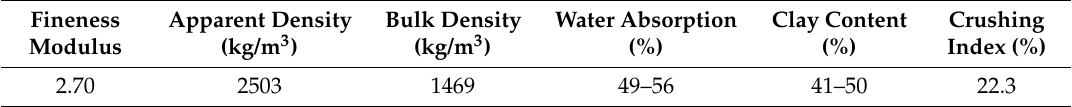
Figure 1. Recycled sand: ( a ) apparent morphology; ( b ) flow chart of recycled sand (RS) preparation with a simple crushing and particle reshaping process. Table 3. Physical property index of class II recycled sand (RS).